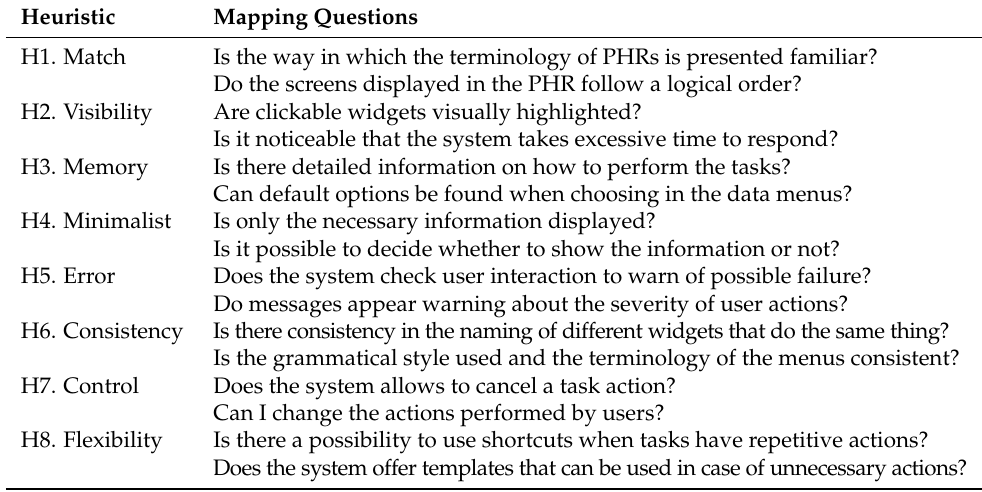
Table 1. Proposed checklist to guide usability